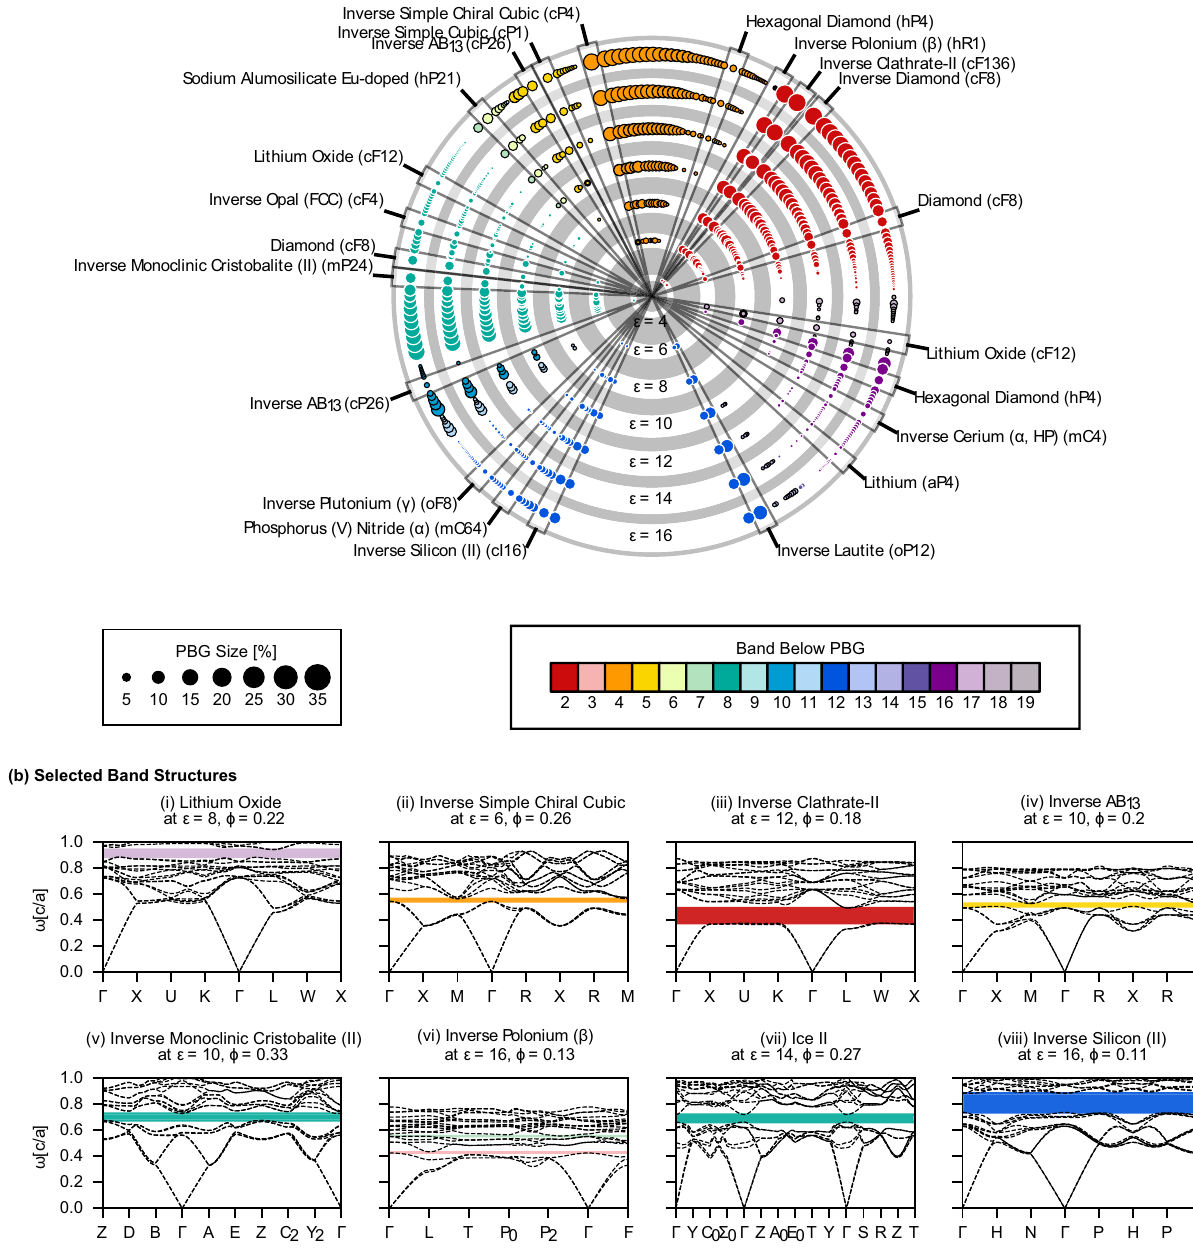
Fig. 1 Overview of PBG properties of nature-inspired structural templates. a The largest PBGs in each PBG location found for each structure computed for ε = 4 – 16, arranged in concentric rings by ε . Circle areas are proportional to the PBG size; colors correspond to the band location of the PBG. Circles are arranged by structure, where each radius corresponds to a single structure at different ε . Some structures are shown more than once since some structures were found to exhibit PBGs in different locations at different fi lling fractions. Structures that have been previously studied or noted elsewhere in the text have been labeled. b Selected band structures, plotted for the fi rst 20 bands across reciprocal space. (i) Lithium oxide, (ii) Inverse simple chiral cubic, (iii) Inverse clathrate II, (iv) Inverse AB 13 , (v) Monoclinic tridymite, (vi) Inverse β -polonium (the only template found to have a PBG between bands 3 – 4), (vii) Ice II, and (viii) Inverse silicon de fi ned by the geometry. The fi rst, which we denote ϕ N , is min( ϕ ) such that the dielectric forms a continuous network, de fi ned for both direct and inverse structures. The second, which we denote ϕ ϕ ) such that the dielectric spheres on any two lattice T , is min( sites touch and can only be de fi ned for direct structures. A